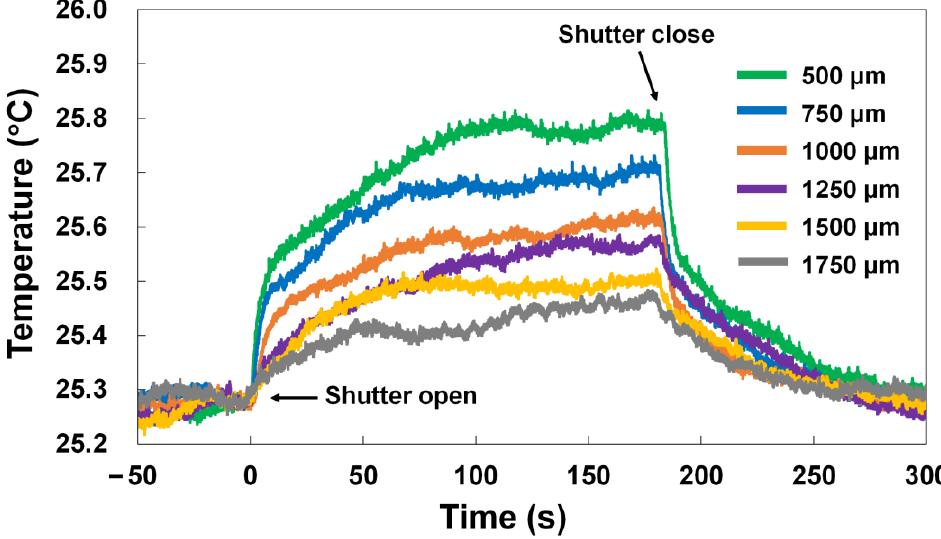
Figure 4. Difference in temperature change according to the distance between the X-ray interaction point and the RTD.